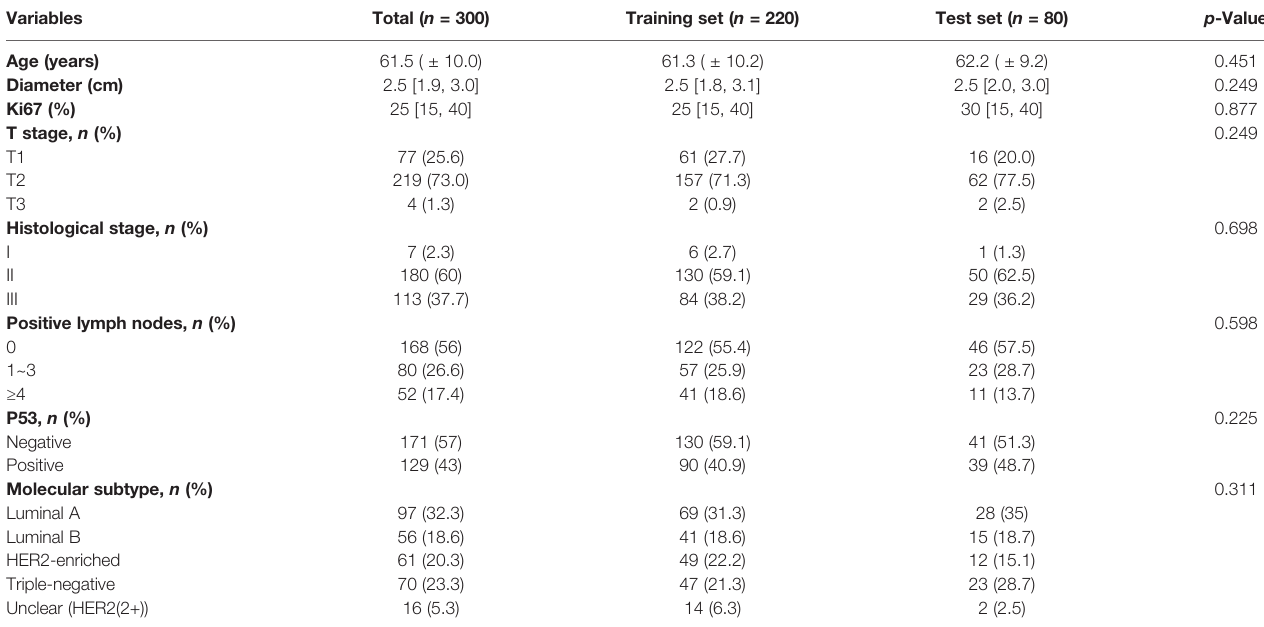
TABLE 1 | Baseline information of the training and test sets. Variables Total ( n = 300) Training set ( n = 220) Test set ( n = 80) p -Value Age (years)